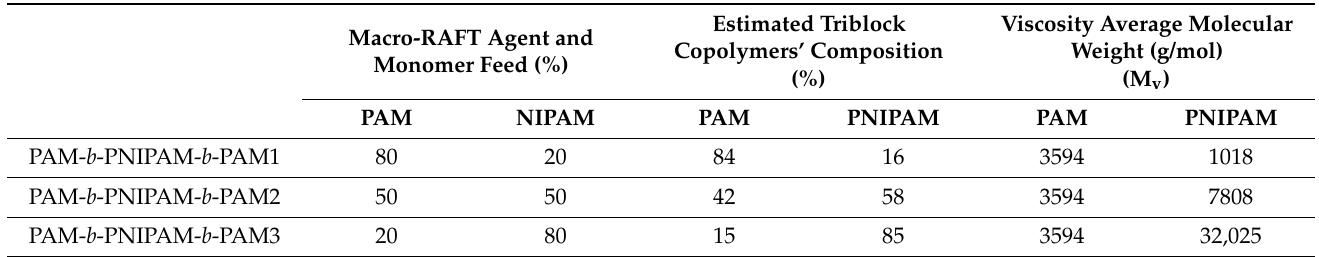
Table 2. Comparison between the macro-RAFT agent (PAM) and the NIPAM monomer feed, the estimated copolymers composition, and the calculated viscous molecular weight (Mv) of each